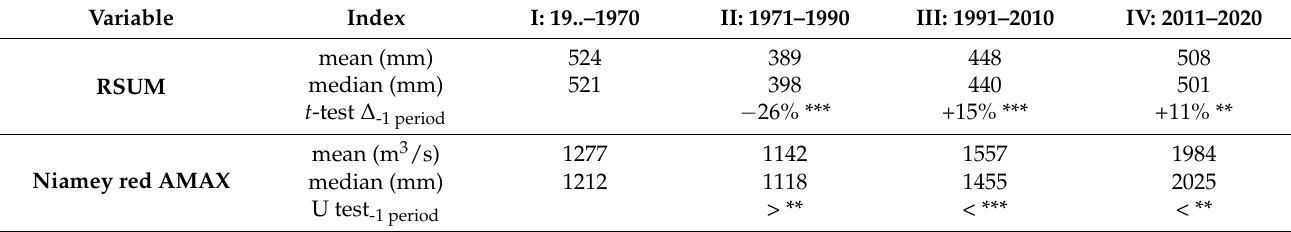
Table 7. Data series segmentation (fixed periods): mean, median and difference of annual precipitation over MNRB (RSUM); mean, median of red AMAX in Niamey. For normally distributed variables, the t-student test ( t -test) was used. For non-normal distributed variables, the Wilcoxon–Mann–Whitney test (U-test) was used. The ∆ -1 period is the difference (%) between the period and the previous ones. Significance of changes: *** p < 0.01, ** p < 0.05, * p < 0.1. Variable